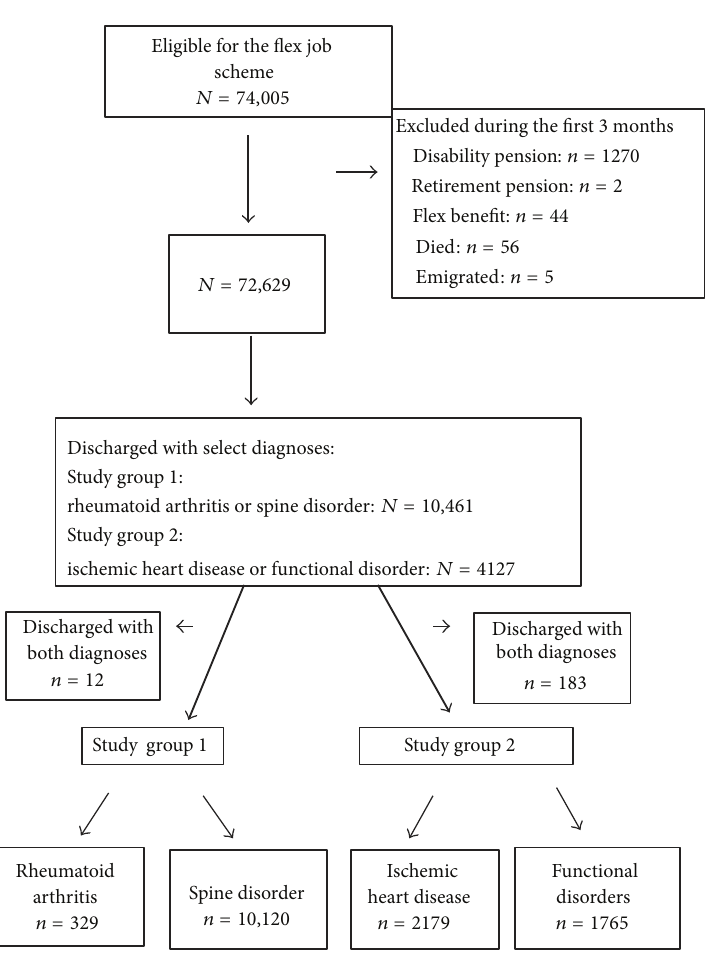
Figure 1: Selection of study participants from adults enrolled in the flex job scheme in Denmark from 2001 to